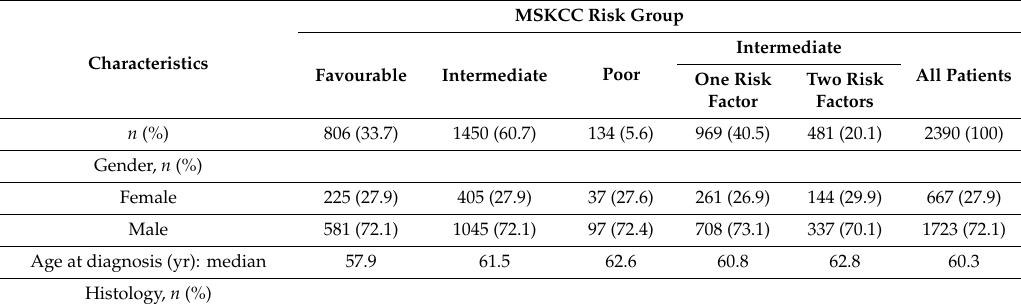
Table 1. Patient characteristics based on MSKCC risk groups and details on MSKCC risk